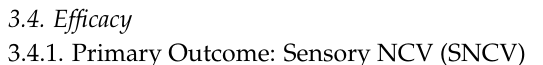
Figure 2. Risk of bias 2.0 graph of the included studies. Table 2. Methodological quality of the included studies according to the risk of bias 2.0.